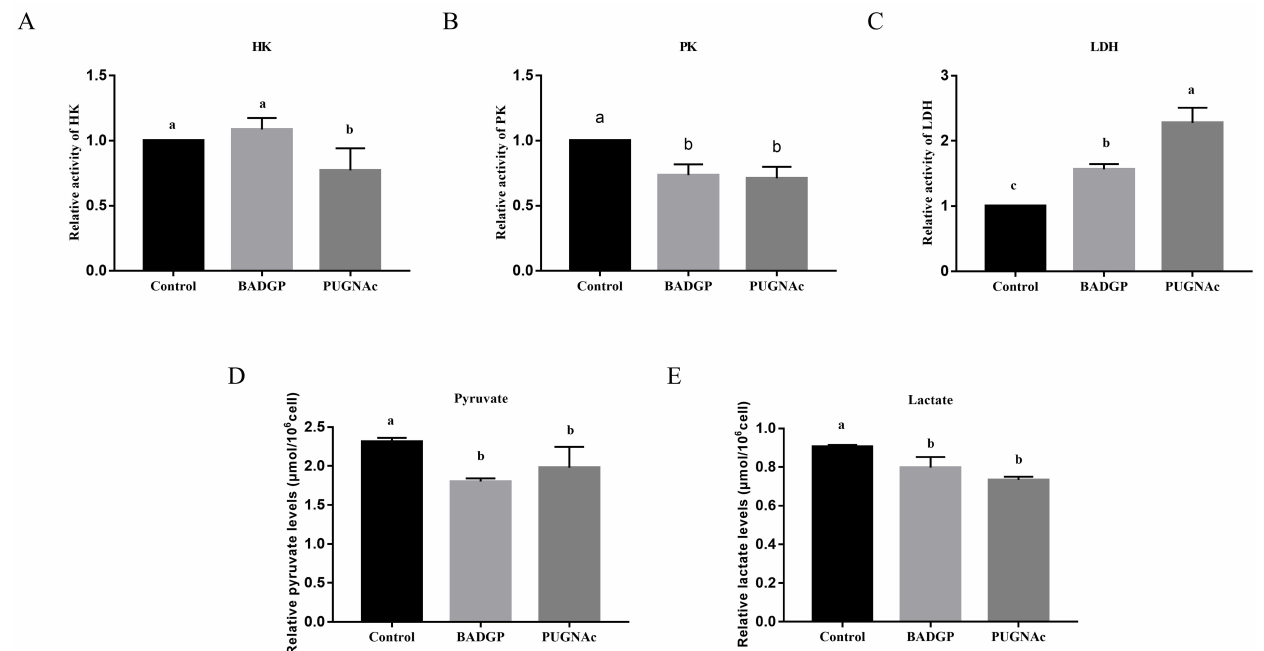
Figure 4. Perturbation of O-GlcNAc cycling in bovine GCs reduces glycolysis. ( A ) Hexokinase (HK) activity. ( B ) Pyruvate kinase (PK) activity. ( C ) Lactate dehydrogenase (LDH) activity. ( D ) Pyruvate production. ( E ) Lactate production. Values are expressed as mean ± SEM of at least three replicates. Different superscript letters (a–c) indicate significant differences ( p <